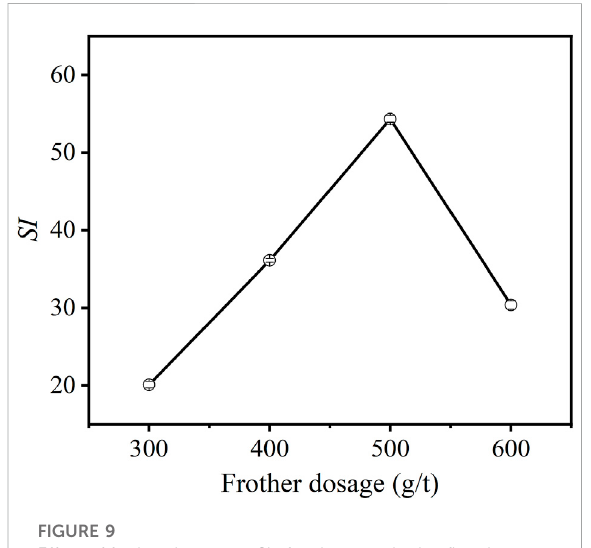
FIGURE 10 Effect of pH on SI of carbon anode slag fl otation (grinding